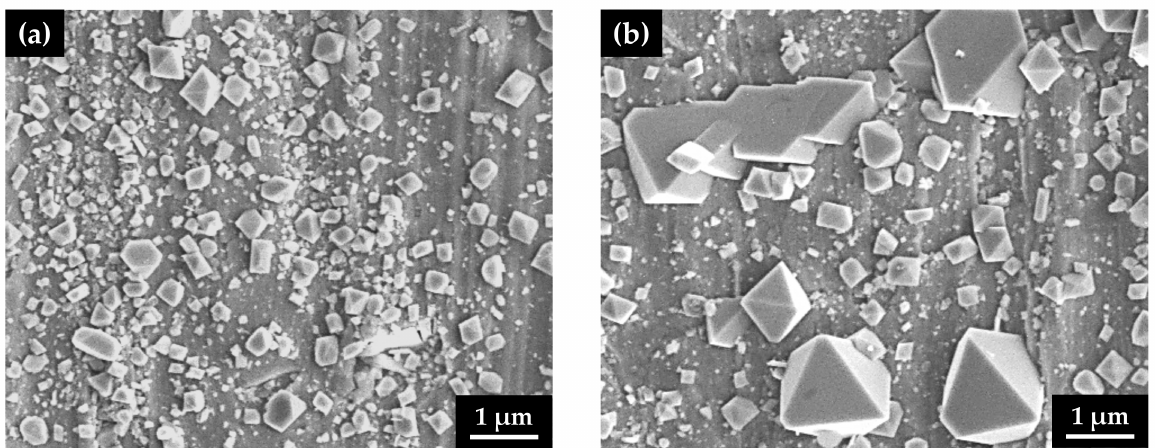
Figure 4. SEM micrographs of the oxidized surfaces of Alloy 600 specimens with two different stress states in simulated PWR secondary water: ( a ) stress-free specimen and ( b ) tensile-stressed